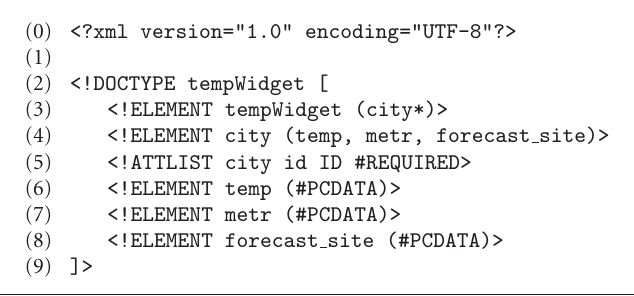
Figure 7: Weather forecaster application: the DTD.